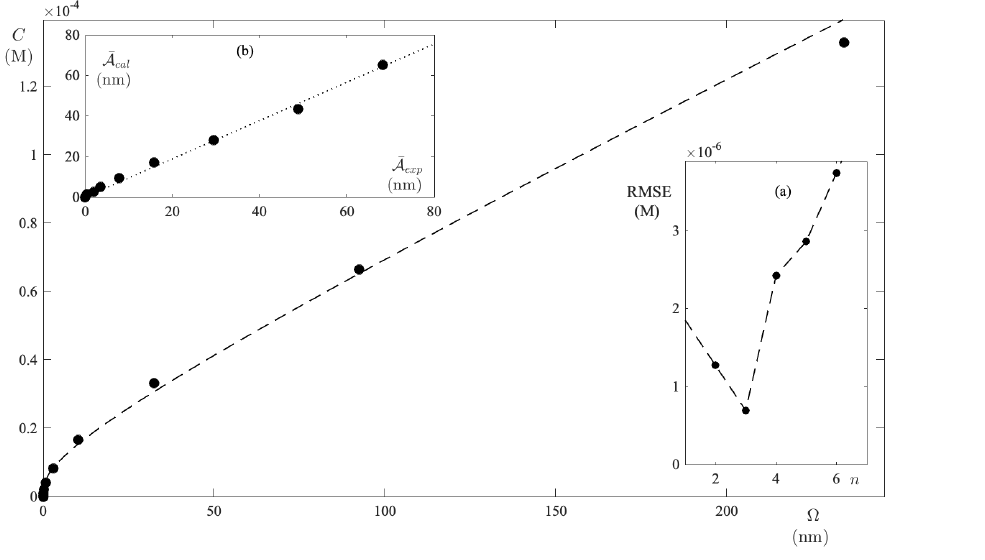
Figure 3. FS molar concentration in UPW as a function of excess absorbance. The dashed curve is the result of fitting to the model equation with n = 3. Panel ( a ) displays the RMSE for each test performed at different n . Panel ( b ) shows the strong correlation between the integral absorbance when recalculated with the new parameters, as well as the experimental